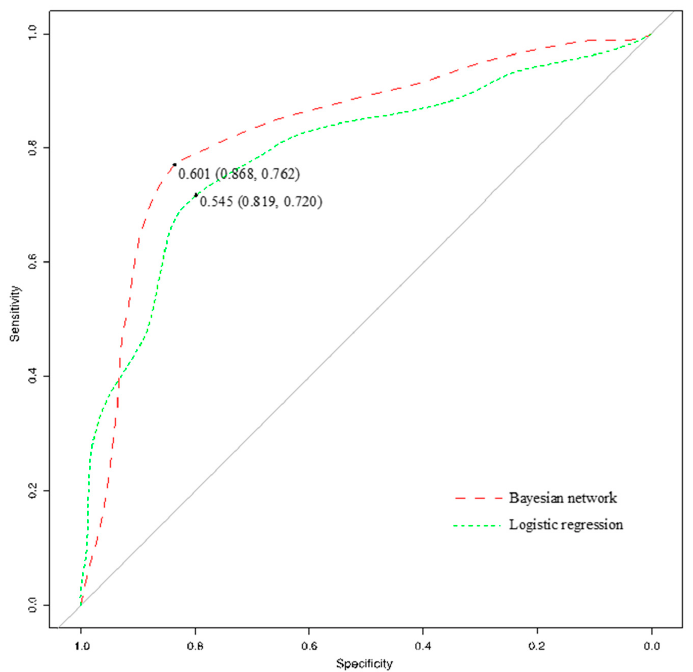
Figure 11. The comparison results of Bayesian network and logistic regression using ROC curve as the performance measure.